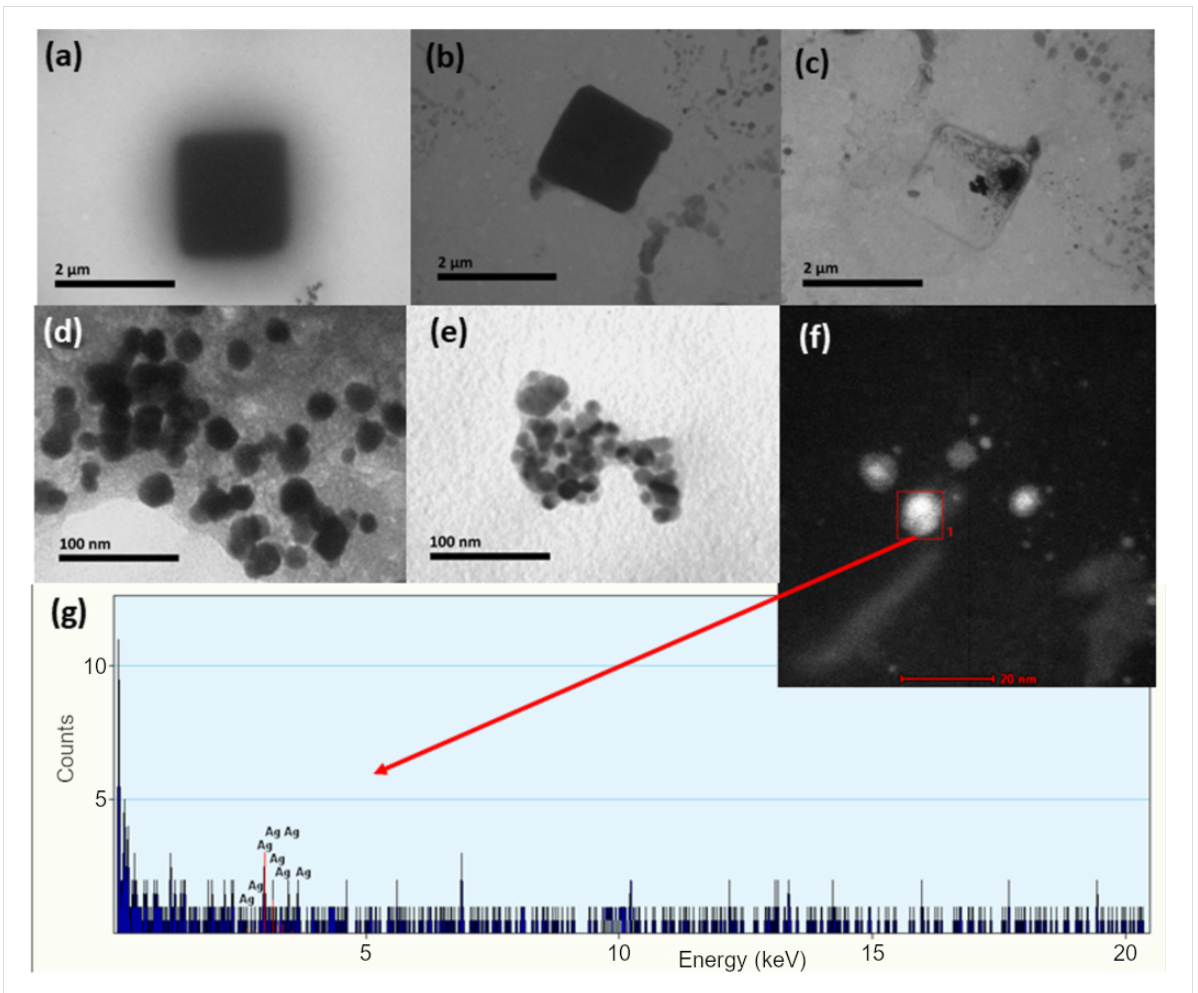
Figure 4: TEM images of objects observed after 30 min of incubation of AgNPs or Ag + in different test media at a concentration of 100 mg Ag/L. (a) PLL-AgNPs in 1% (w/v) of blood plasma, (b) PLL-AgNPs in PBS, (c) electron-beam-induced transformation of cubic nanocrystals formed after incubation of AgNPs in PBS, (d) AgNPs formed after Ag + incubation in 1% (w/v) of liver homogenate, (e) AgNPs formed after Ag + incubation in 1% (w/v) of brain homogenate, (f) HAADF images of AgNPs formed after incubation of Ag + in brain homogenate, (g) EDX analysis of nanoscale objects found in brain homogenates after incubation with AgNO 3